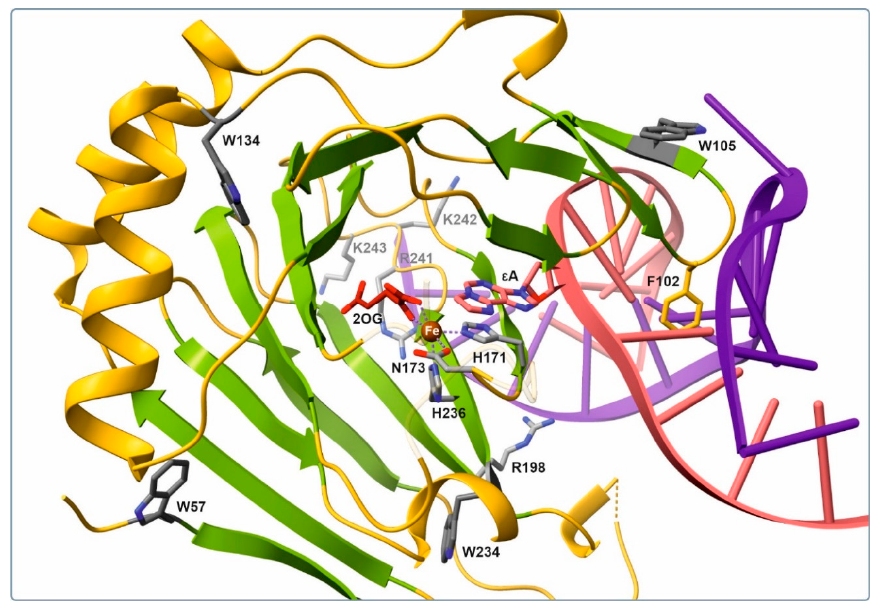
Figure 1. Closeup view of the active site of ALKBH2 with Fe (brown), 2OG (red), and ε A-containing dsDNA (pink/violet) according to Protein Data Bank structure 3RZK [18]. Key coordinating and intercalating amino acid residues are indicated. For clarity, two protein regions (aa 174–179 and 256–258) are shown as 90% transparent cartoons.